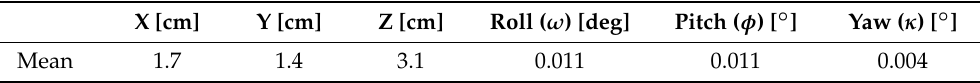
Table 2. Precision of the camera position and attitudes.